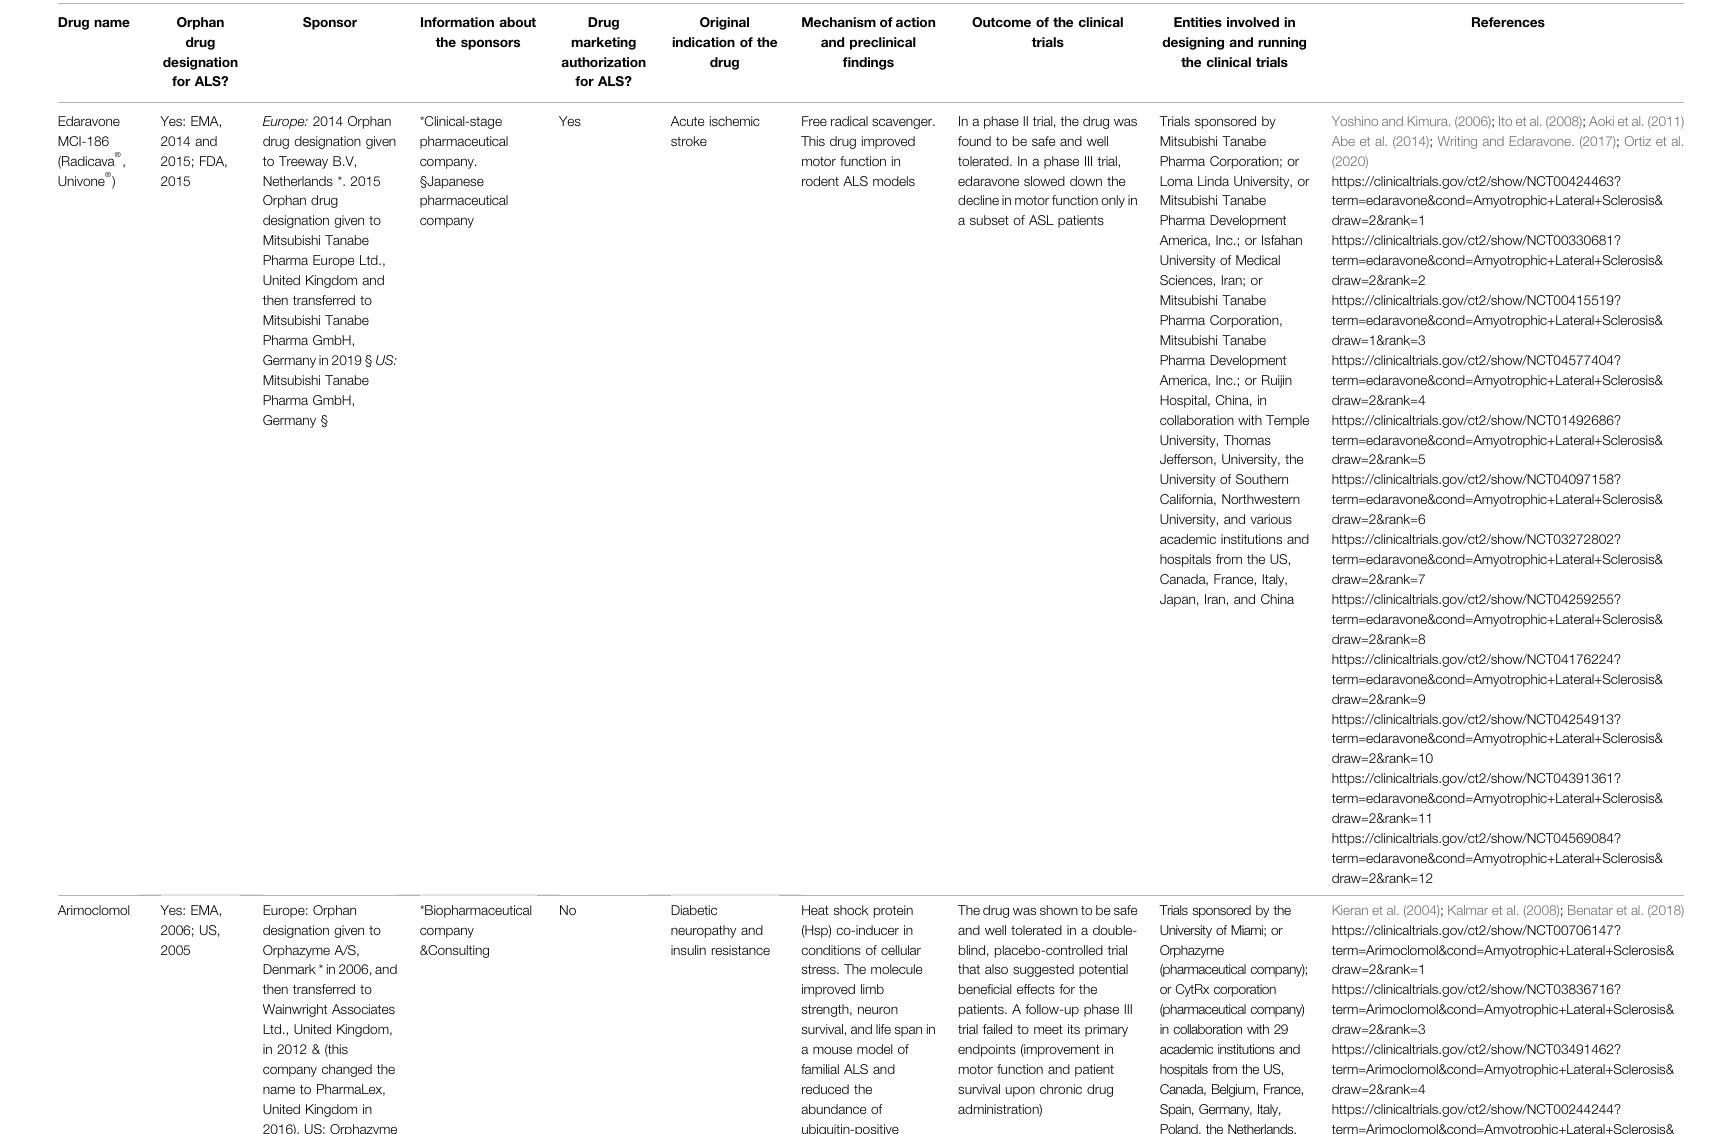
TABLE 4 | List of the repurposed drugs, with and without orphan designation or drug marketing authorization for amyotrophic lateral sclerosis (ALS) mentioned in this article. The sponsors (entities involved in making the orphan designation request to the EMA or the FDA) and the public or private organizations involved in designing and running the clinical trials are detailed. N/A (cid:1) non-applicable. Drug